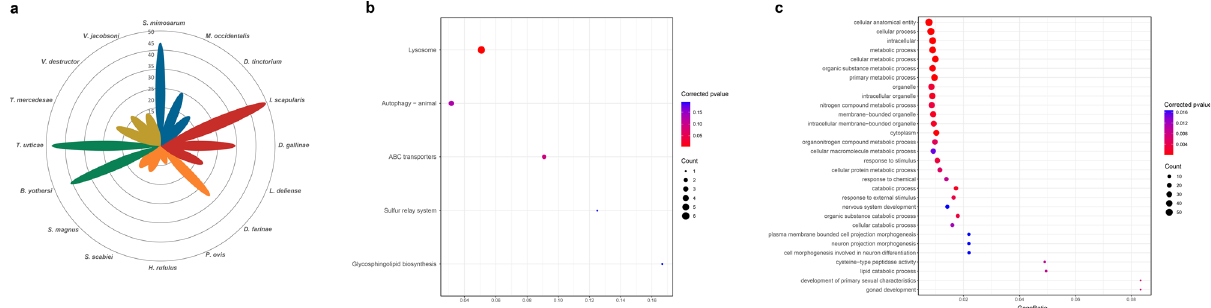
Fig. 3 Adaptation of herbivorous mites. a Gene counts related to the P450 gene family of sixteen species. b KEGG enrichment of the 200 most highly expressed genes in herbivorous mites. c GO enrichment of the 200 most highly expressed genes in herbivorous mites. KEGG Kyoto Encyclopedia of Genes and Genomes, GO Gene Ontology.